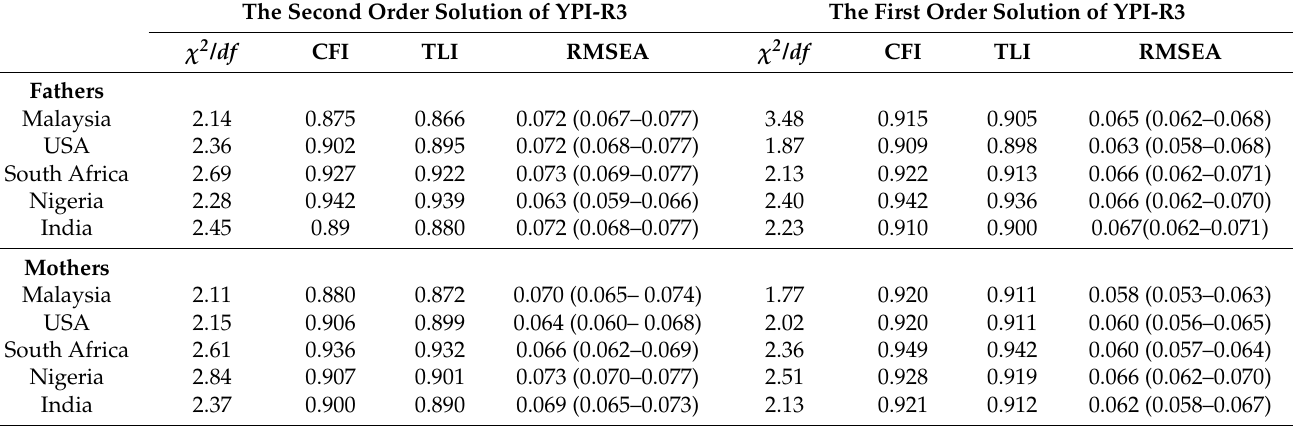
Table 8. Fit Indices for the Three-Second Order Factor Solution and the Ten First Order Solution of the